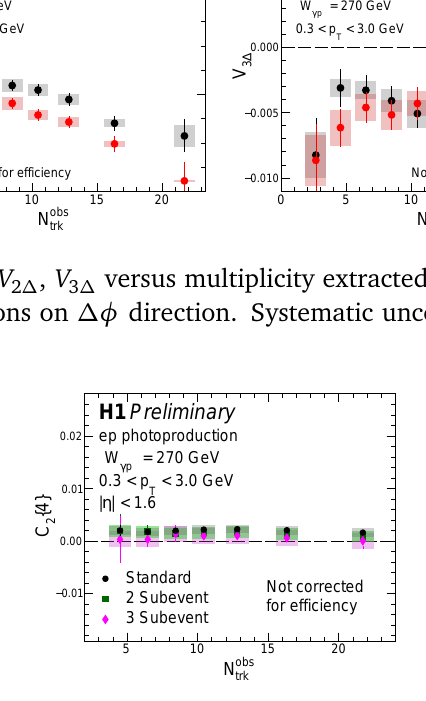
( 4 ) versus multiplicity in ep photoproduction process at Figure 7: C 2 within standard, 2-subevent and 3-subevent